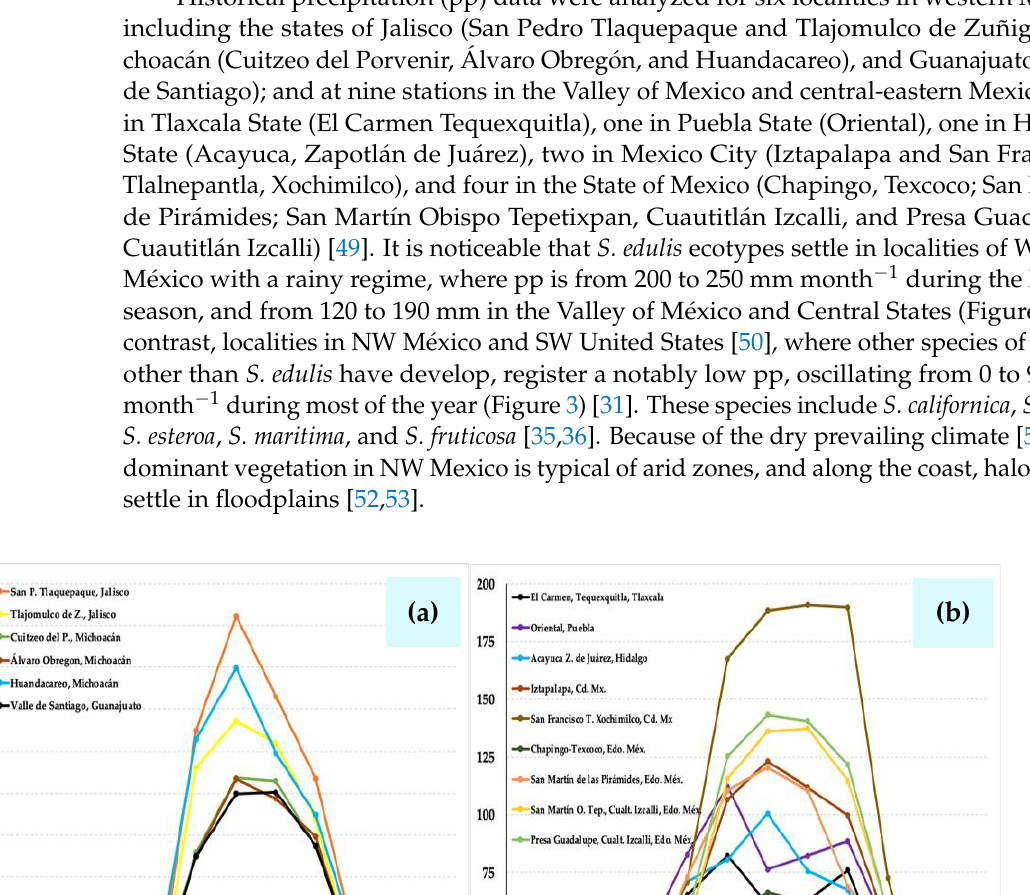
Figure 3. Historical precipitation data from nine stations in NW Mexico (Baja California Sur and Sonora) and the SW region of the USA (California), where several species of Suaeda are reported.